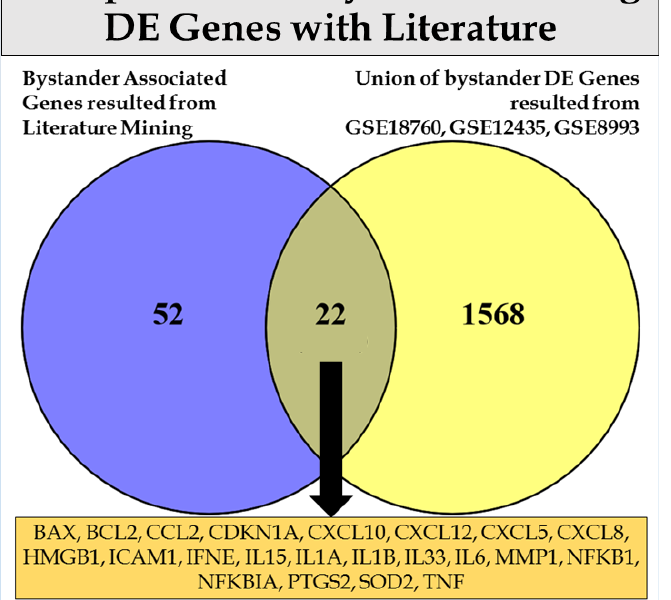
Figure 3. Venn diagram comparing a gene list associated with bystander effects derived from literature mining from the study of Nikitaki et al. [46] and a union of DE genes resulting from the statistical analysis of the GSE18760, GSE12435, and GSE8993 datasets for the comparisons of bystander vs. control samples. The comparison resulted in 22 common genes.